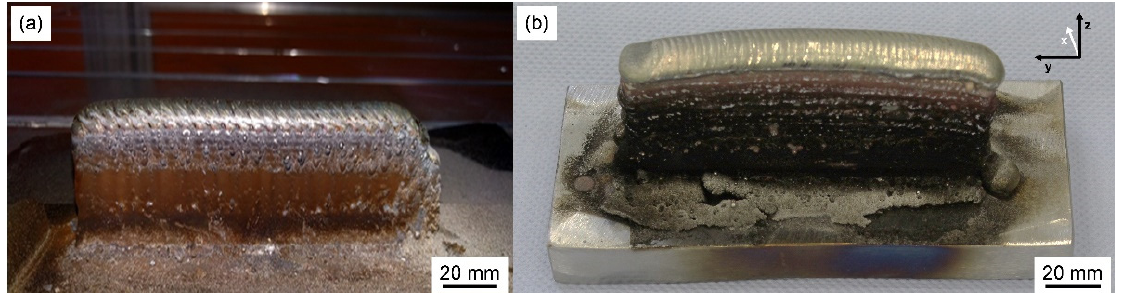
Figure 4. Images of as-fabricated wall specimens: ( a ) W1 produced in air; ( b ) W2 produced in an argon-purged processing chamber.